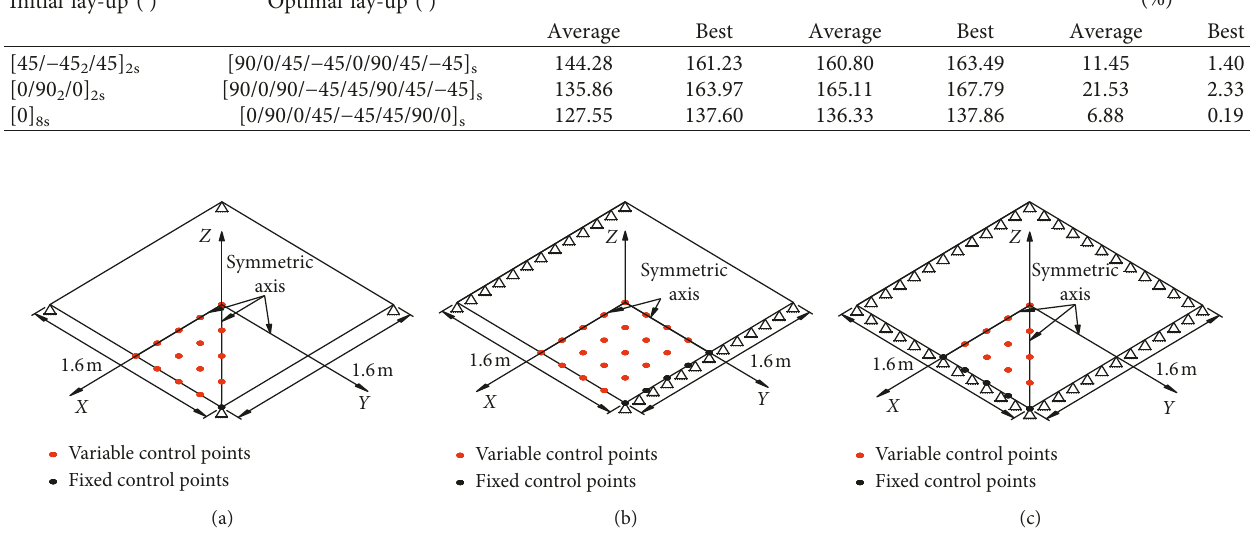
Figure 11: Location of control points through Approach 1. (a) Shell 1. (b) Shell 2. (c) Shell 3.